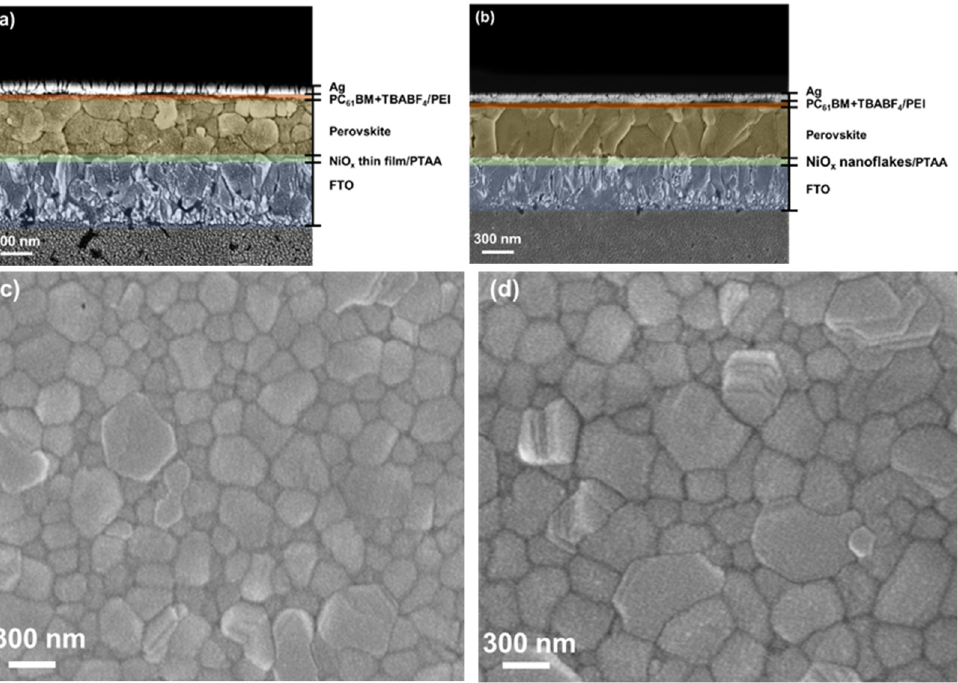
Figure 7. Cross-sectional SEM micrographs of PSCs based on the NiO x ( a ) thin film and ( b ) nanoflakes as the HTL; top-view SEM micrographs of the perovskite deposited on the ( c ) NiO x thin film/PTAA and ( d ) NiO x nanoflakes/PTAA.